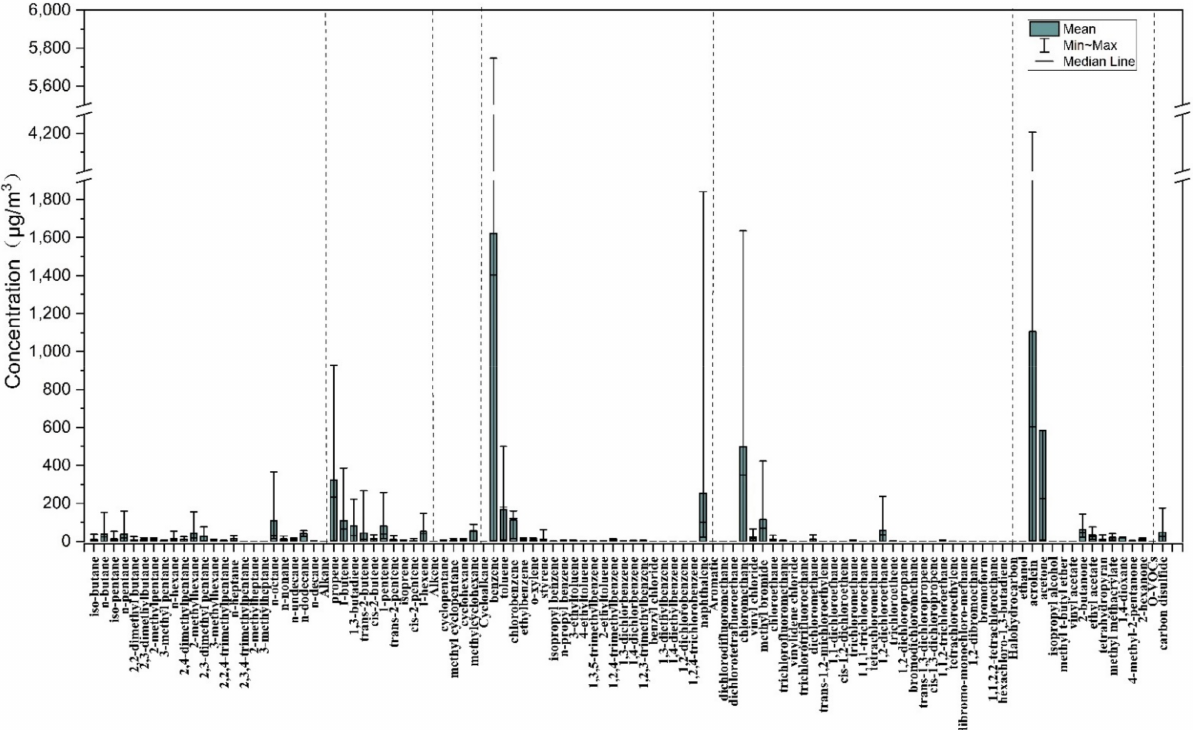
Figure 1. VOCs concentration